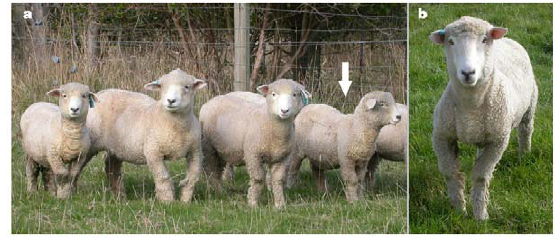
Figure 1. Corriedale sheep with rickets. ( a ) 1 K -year-old Corriedale sheep with inherited rickets showing angular limb deformities of the forelimbs and lordosis of the spine in the mid-thoracic region (white arrow). ( b ) 1 K -year-old Corriedale sheep with inherited rickets showing combined varus and valgus or ‘‘windswept’’ deformity of the forelimbs.